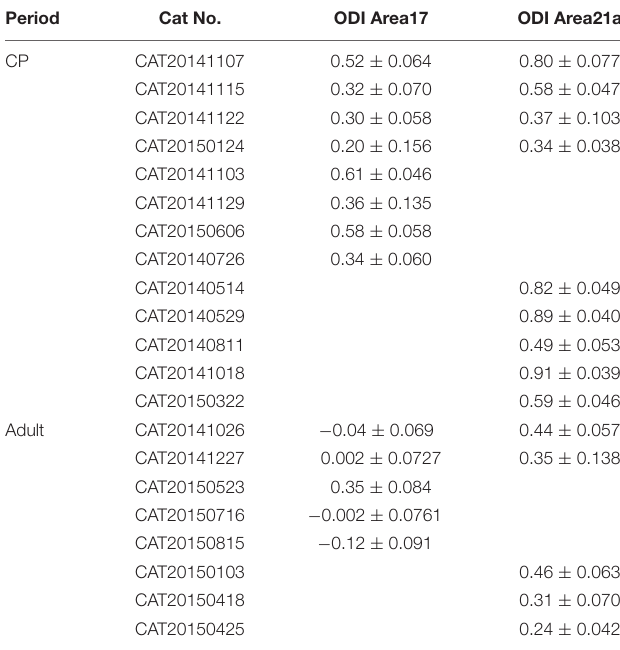
TABLE 1 | Effects of MD measured by electrophysiology. Period Cat